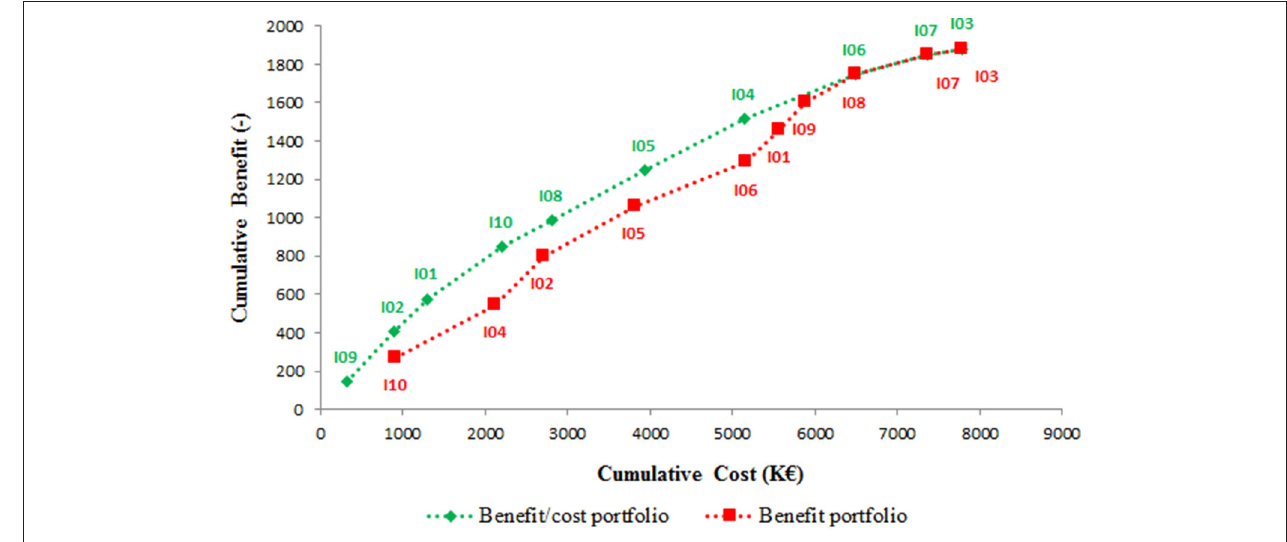
FIGURE 4 | Prioritization of the intervention